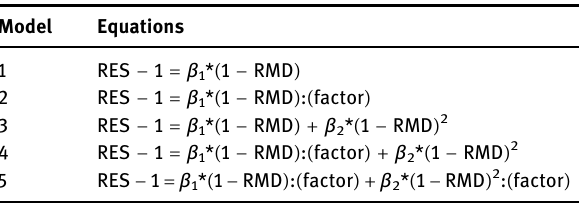
Table 2: Speci fi cation of the models fi tted to the data Model